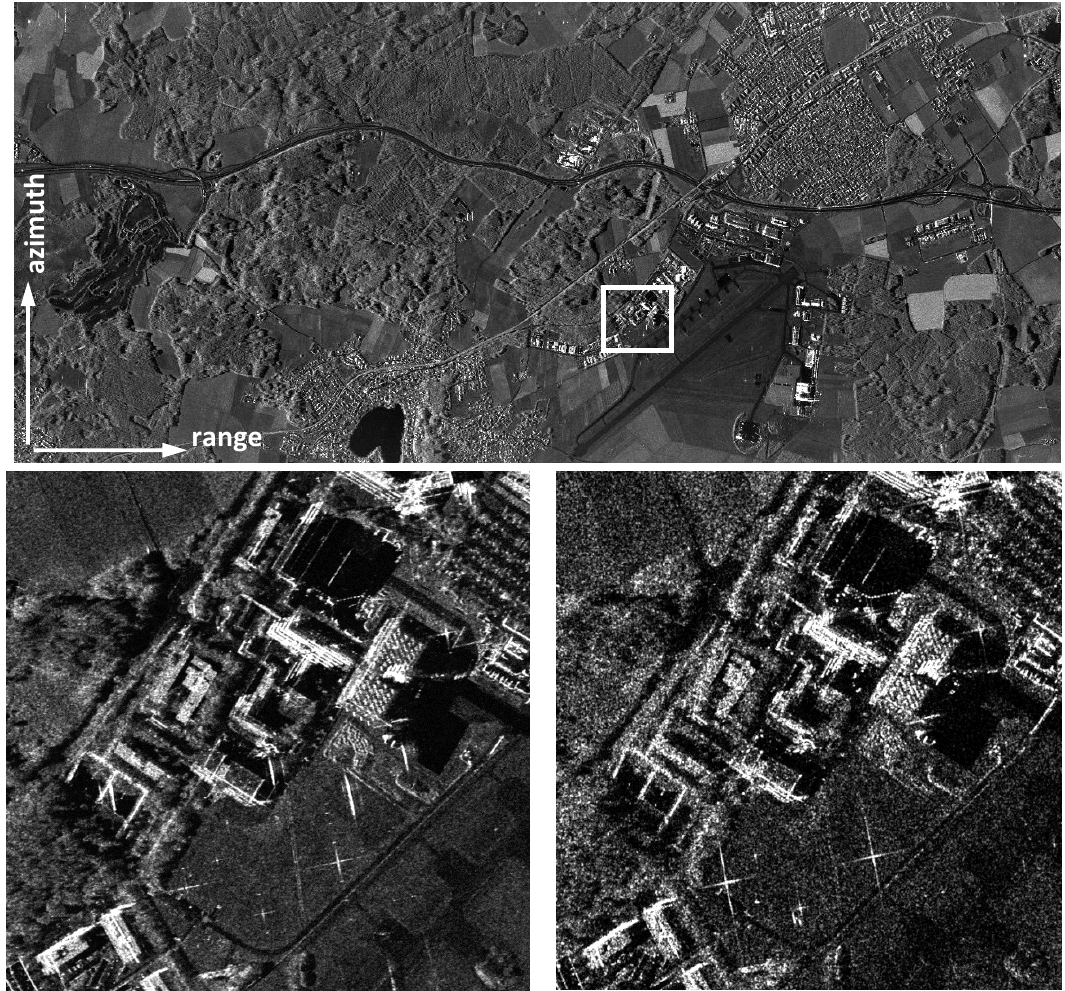
Figure 6. ( Top ) TerraSAR-X staring spotlight (ST) experimental acquisition example over Oberpfaffenhofen, Germany with five azimuth looks, incidence angle 35.6°, PRF 3786 Hz, scene extent 8.8 km × 3.6 km in ground range and azimuth, respectively. The single look resolution is 1.00 m in ground range and 0.21 m in azimuth. ( Bottom ) Zoom into staring image ( left ) and HS image ( right ). The geometric resolution in both zooms is about 1 m in azimuth and ground range, i.e., the staring image is composed of five looks, while the HS sliding image comprises only one.